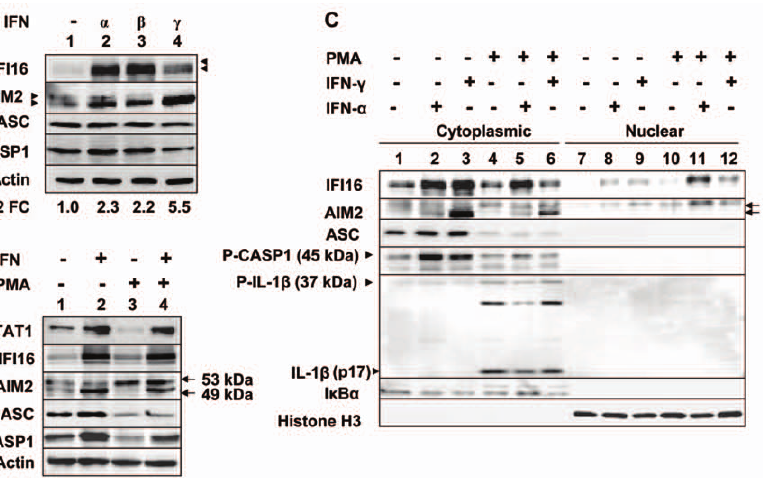
Figure 3. IFNs and PMA differentially regulate the expression of the IFI16, AIM2, and inflammasome proteins and their sub-cellular localization. ( A ) Total cell extracts were prepared from THP-1 cells either left untreated (control) or treated with IFN- a (Universal IFN; 1000 u/ml), IFN- b (1000 u/ml), or IFN- c (10 ng/ml) for 12 h. Extracts containing approximately equal amounts of proteins were analyzed by immunoblotting using antibodies specific to the indicated proteins. The arrowheads indicate different isoforms of IFI16 protein. FC, indicates the fold change in the levels of the AIM2 protein with respect to the control (lane 1). ( B ) THP-1 cells were either left untreated (lane 1) or treated with IFN- a (1000 u/ml for 16 h) alone (lane 2), treated with PMA (1 m M for 3 h; lane 3) alone or both PMA and IFN- a (lane 4). After the treatment, total cell extracts containing approximately equal amounts of proteins were analyzed by immunoblotting using antibodies specific to the indicated proteins. The arrowheads indicate two protein bands (53 and 49 kDa) of the AIM2 protein. ( C ) THP-1 cells were either left untreated (lanes 1 and 7) or treated with IFN- a (1000 u/ml for 16 h) alone (lanes 2 and 8), IFN- c (10 ng/ml for 16 h) alone (lanes 3 and 9), PMA (1 m M) alone (lanes 4 and 10), both PMA and IFN- a (lanes 5 and 11), or PMA and IFN- c (lanes 6 and 12) . After the treatment, cells were fractionation into the cytoplasmic and nuclear fractions. The fractions containing approximately equal amounts of proteins were analyzed by immunoblotting using antibodies specific to the indicated proteins. Detection of the I k B a protein only in the cytoplasmic fraction and histone H3 in the nuclear fraction served as the quality control for the purity of cell fractionations.